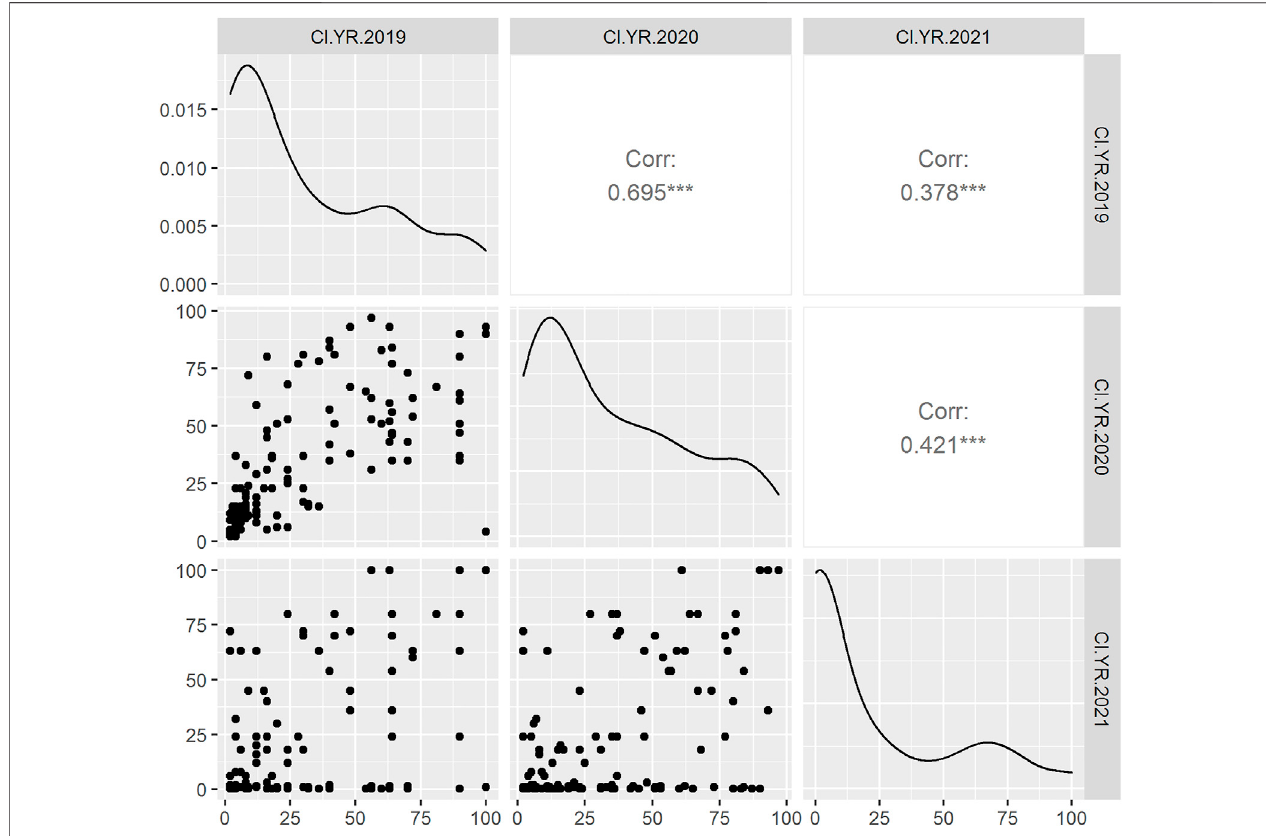
FIGURE1| Scatterplot(lowertriangle)withthedistributionofphenotypicdataduring2019,2020,and2021 fi eldyearsfromlefttorightanticlockwise,respectively; density plot (diagonal line) and Pearson correlation analysis (upper triangle) between the 3 years of DH population in fi eld condition. The X -axis and Y -axis represent the stripe rust coef fi cient of infection